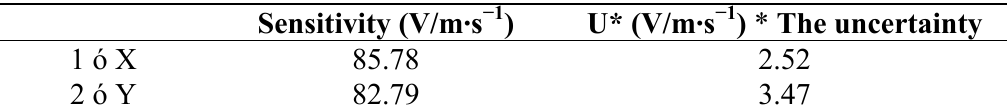
Table 4. GS-11D Sensitivity.